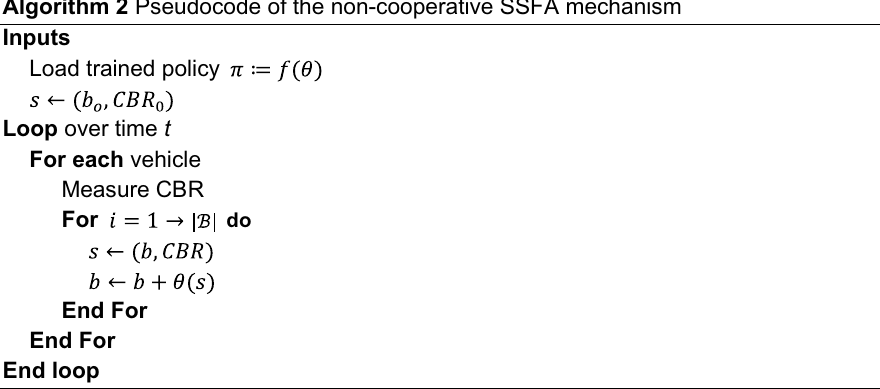
Algorithm 2 Pseudocode of the non-cooperative SSFA mechanism